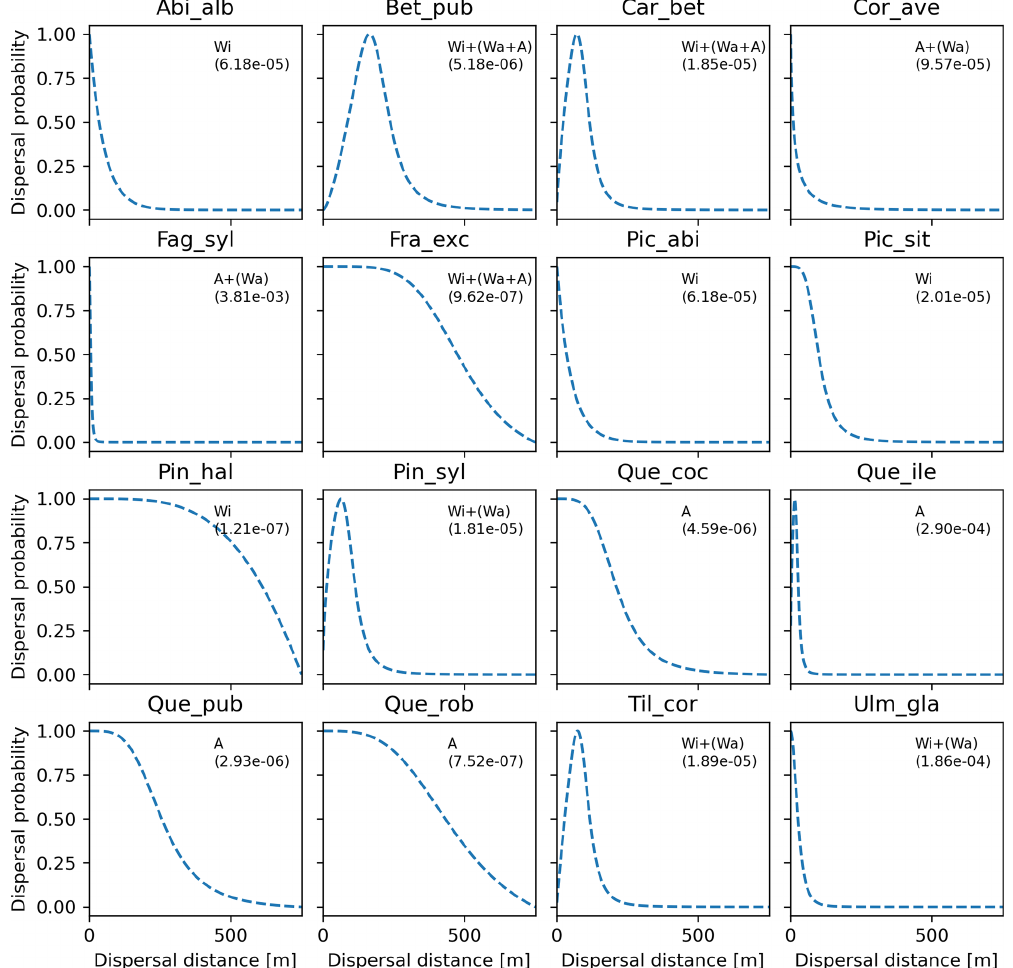
Figure 6. Best fat-tailed kernel shapes per species. See Table B3 for the corresponding parameter values: kernel function, SDD d , LDD d , and shape parameter b . Each species-specific kernel function is implemented as PDF in Eq. (A3) for both the SDD and LDD component. Dispersal probabilities of each kernel are scaled in the [0–1] range for comparison. Maximum values of unscaled probabilities are indicated in parentheses. Species-specific dispersal mechanisms: Wi: wind; Wa: water; B: bird; A: animals, with secondary mechanisms in parenthesis (Table